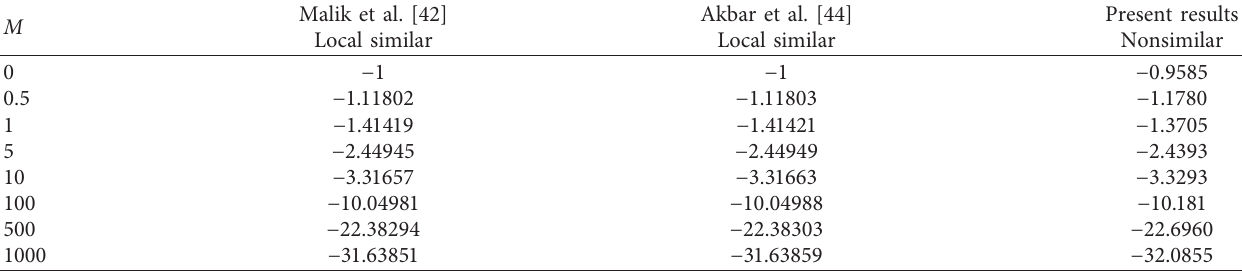
Table 2: Skin friction values comparison for different magnetic field parameters and c � 0 and A � 0, for n � 1.